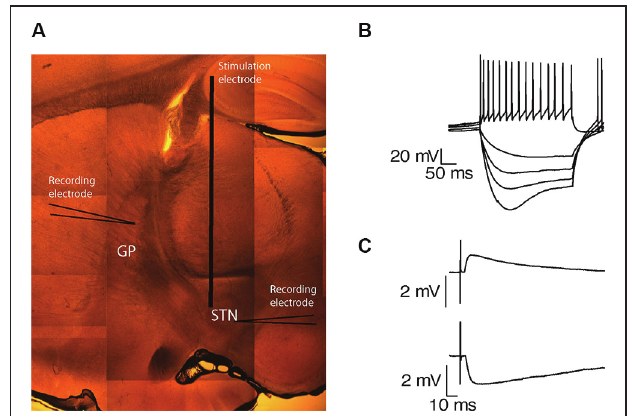
FIGURE 1 | Preservation of functional connectivity between the GP and the STN. (A) A sagittal brain slice containing the STN and the GP. (B) Voltage responses of a subthalamic neuron to injection of positive and negative current steps. (C) EPSP recorded in the GP in response to STN stimulation (upper trace). IPSP recorded in the STN in response to GP stimulation (lower